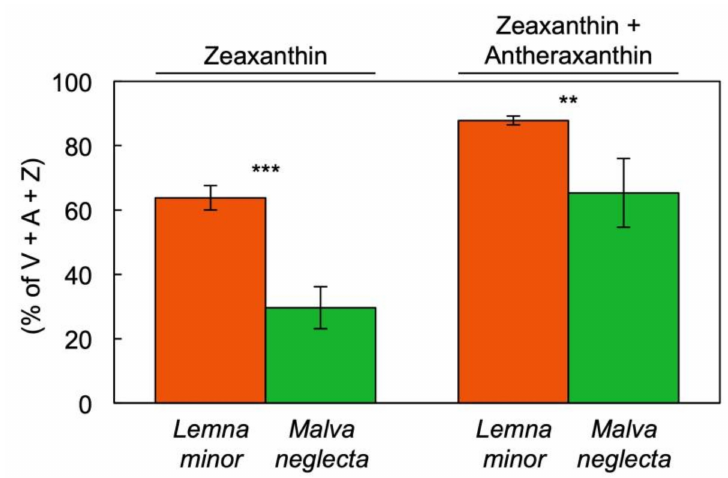
Figure 8. Conversion state of the xanthophyll cycle pool to zeaxanthin (Z) or zeaxanthin + antherax- anthin (A) under full sun (1600 µ mol photons m − 2 s − 1 ) in fronds of Lemna minor (orange) and leaves of Malva neglecta (green) growing naturally in Superior, CO, USA. Mean values ± standard deviations; n = 4. Significant differences are denoted by asterisks; ** = p < 0.01, *** = p < 0.001. V = violaxanthin.